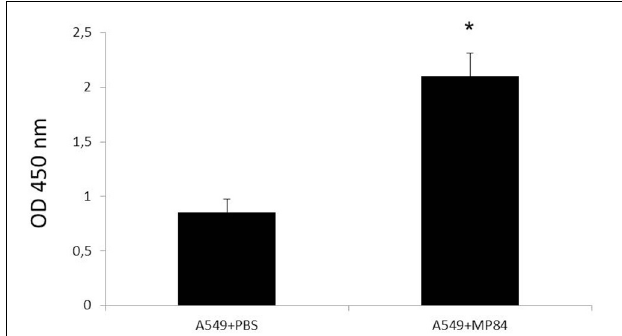
FIGURE 5 | Binding of recombinant MP84 to A549 cells was determinated by ELISA. Incubation of epithelial lung cells with recombinant MP84 for 1h, for further reaction with the anti-histidine antibody and a mouse anti-IgG HRP conjugated, shows that A549 cells are able to bind recombinant MP84. Control preparations were submitted to the same steps, but the recombinant MP84 was replaced by PBS. ∗ p < 0 .